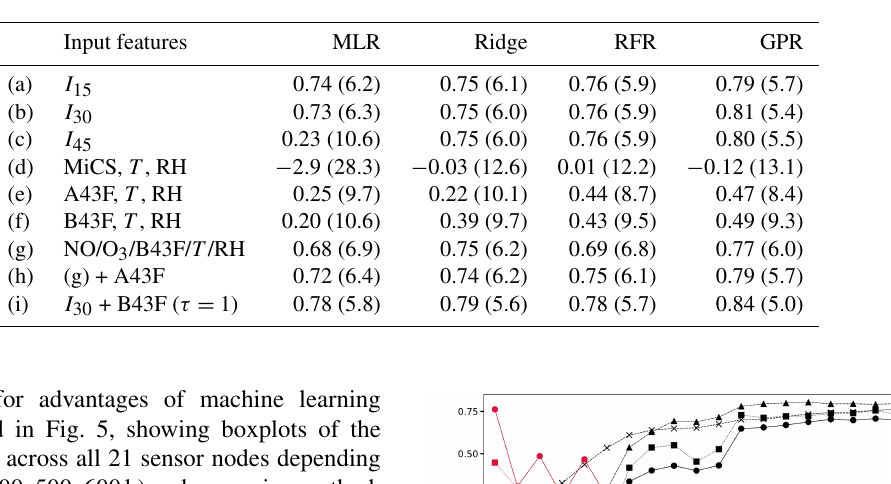
Table 2. Average NO 2 sensor skill depending on the selection of predictors. Shown are average R 2 scores and root mean squared errors (in brackets; units µgm − 3 ). Results are averaged over the 21 low-cost sensor nodes with 600 hourly training samples each, and the evaluation is carried out for 220 test samples each. RH stands for relative humidity, and T stands for temperature.